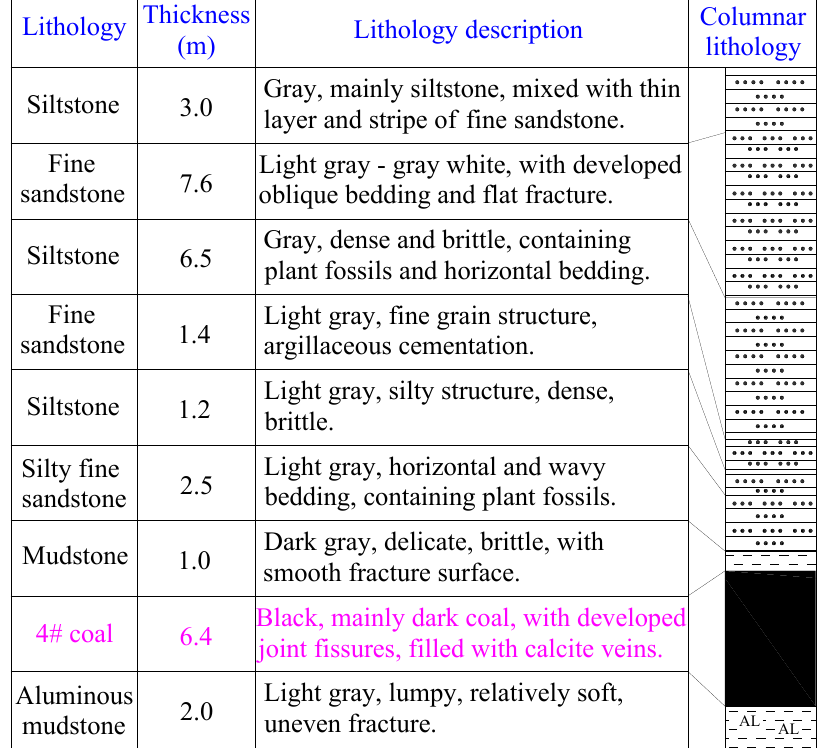
Figure 1. Occurrence conditions of the roof and the floor of the coal seam.